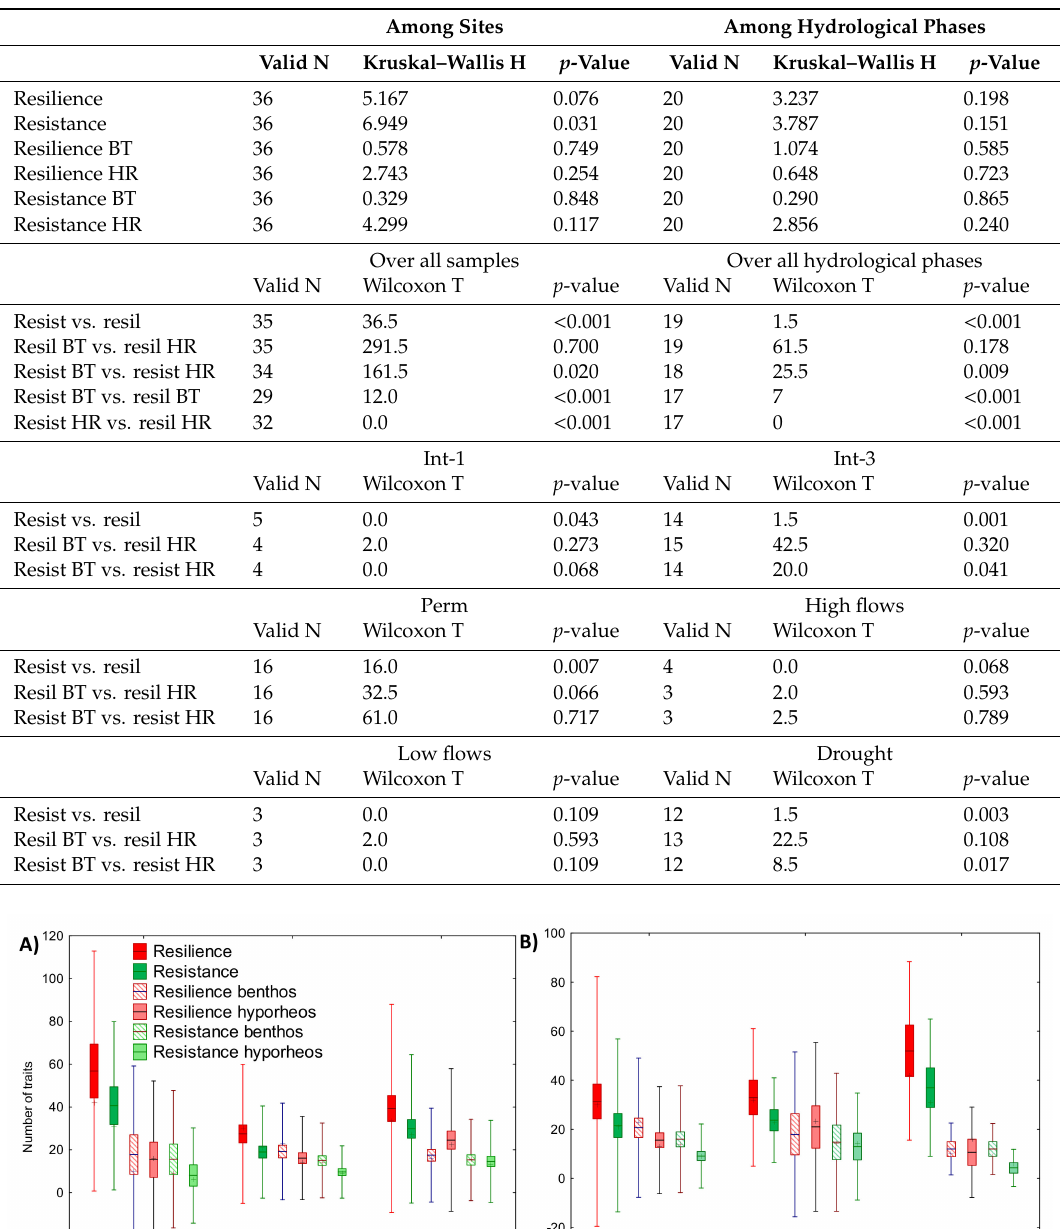
Table 3. Results of Kruskal–Wallis ANOVA by ranks and Wilcoxon matched pair tests. Comparisons for hydrological phases for intermittent sites only. Resil = resilience; resist = resistance; BT = benthos; HR = hyporheos. Station codes as in Figure 3.